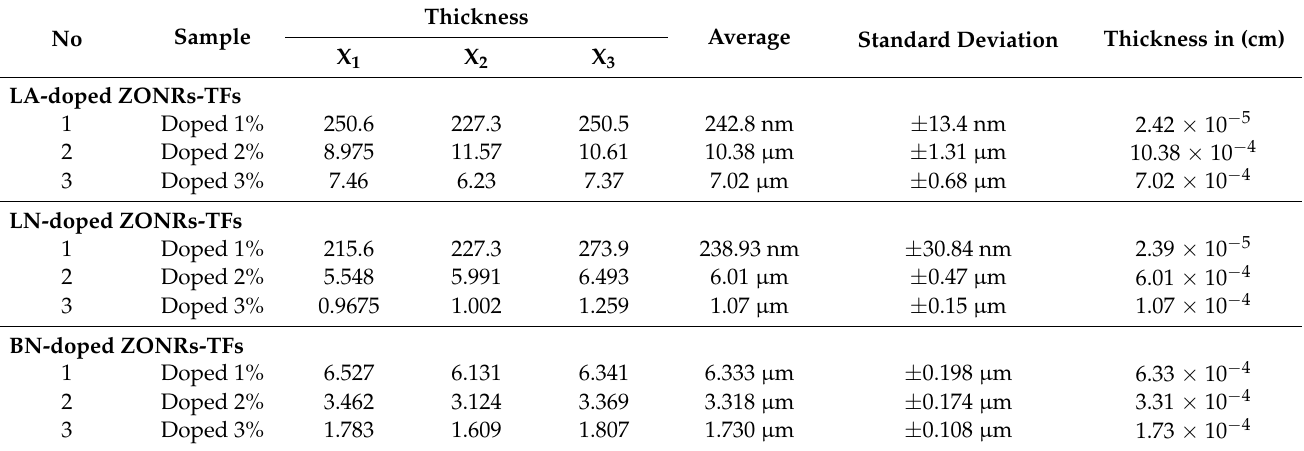
Table 2. Average thickness of LA-, LN-, and BN-doped ZONRs-TFs was obtained from FESEM image